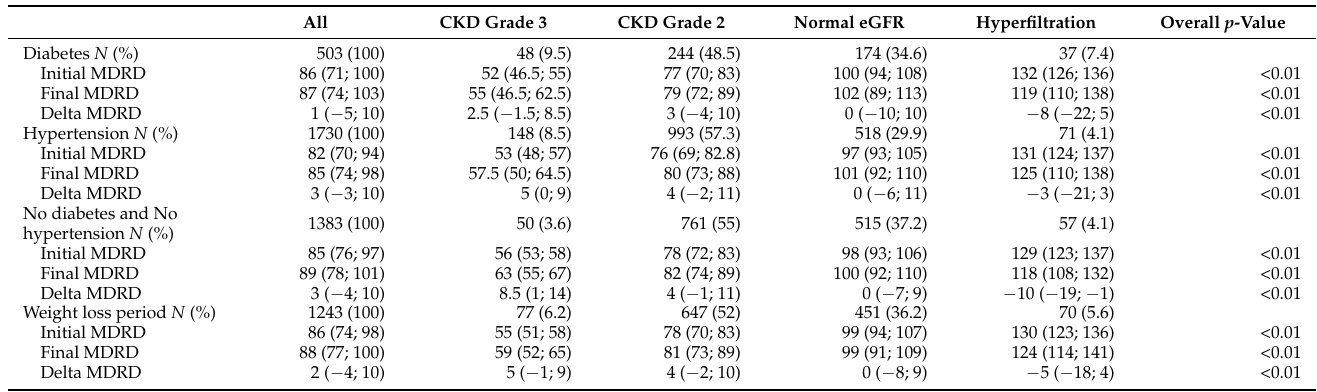
Table 4. Sensitivity